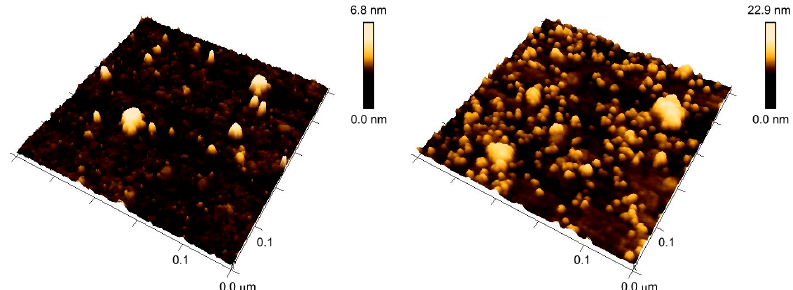
Figure 4. Distribution of citrate-capped AuNPs deposited on nonfunctionalized gold surfaces. AFM images show the distribution of AuNPs after one minute ( left ) and two hours ( right ) of immersion, respectively.